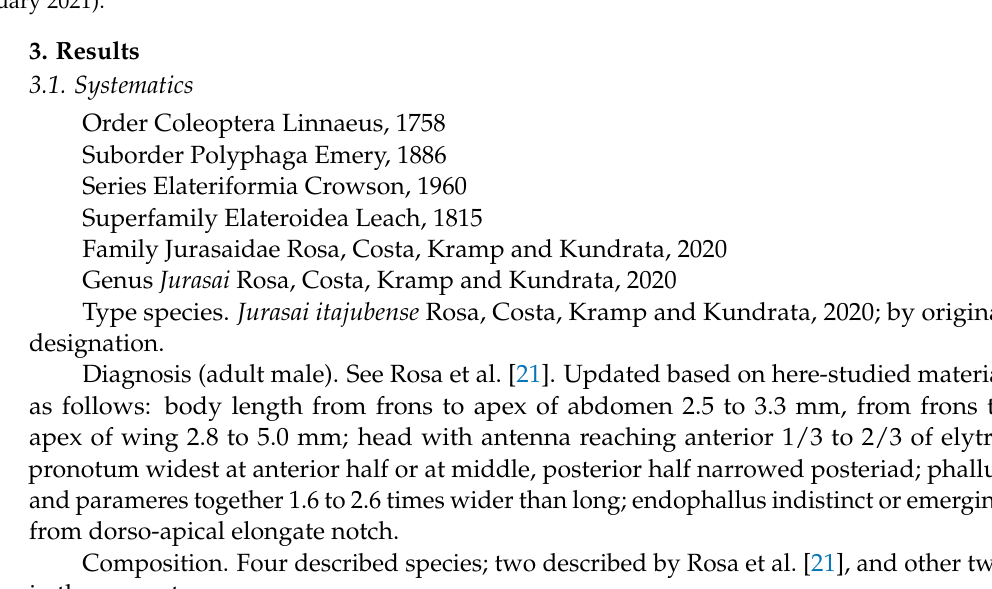
Figure 8. Distribution of Jurasaidae. Green hue represents the dominium of Atlantic Forest and orange hue represents the Brazilian semiarid region, including the Caatinga. Raster data available at https://www.naturalearthdata.com (accessed on 19 January 2021). Vegetation vector shapefiles available at https://www.ibge.gov.br/geociencias/downloads-geociencias.html (accessed on 19 January 2021).